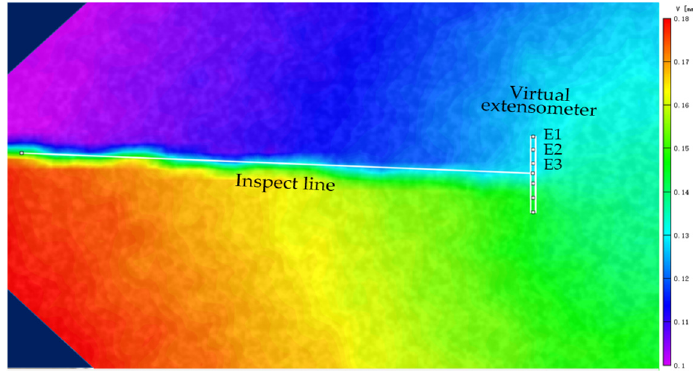
Figure 4. Crack length and Δ CTOD measurement via the DIC technique.